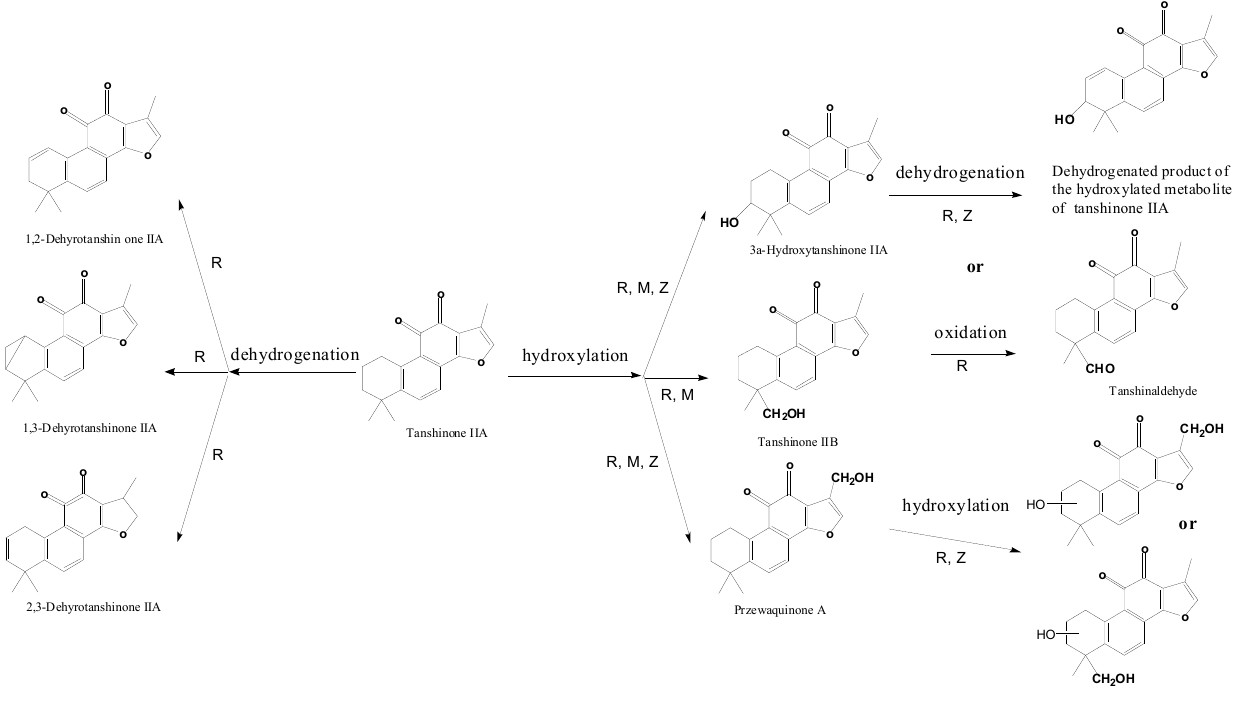
Figure 7. Comparison of metabolic pathways of TIIA between zebrafish and the current metabolism methods. Note: R represents Rat, M stands for Rat liver microsomes and Z for